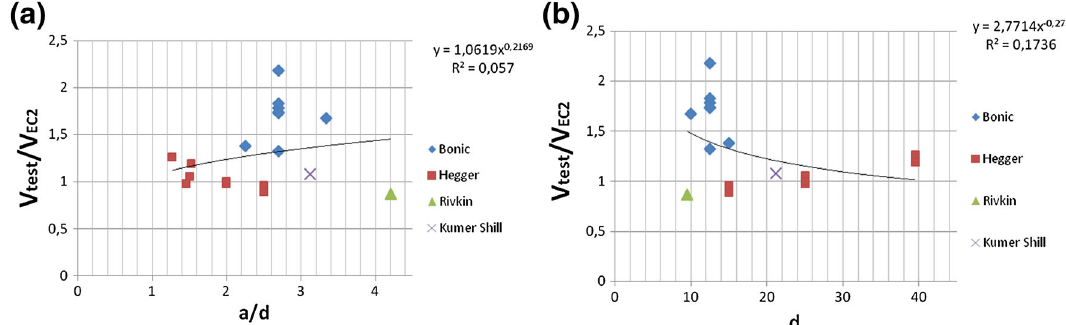
Fig. 23 Comparison of results of punching tests according to the proposed method of assessment regarding: a footing depth d ; b shear slenderness a / d